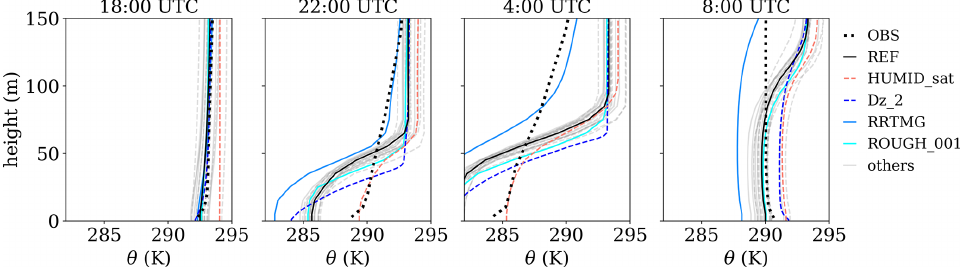
Figure 9. Vertical profiles of mean potential temperature as measured at Cabauw (OBS) and for all cases listed in Table 5. Only case REF and some relevant cases are highlighted; all others are shown in gray.